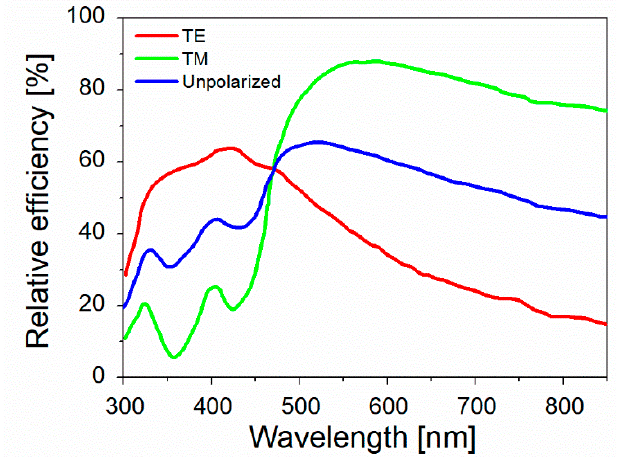
Figure 19. Example of reflectivity for an 1800 groove / mm grating optimized for use between 450 and 850 nm. Transverse electric (TE) indicate that the electric field of the radiation is polarized perpendicular to the plane of incidence; transverse magnetic (TM) indicate that the magnetic field of the radiation is polarized perpendicular to the plane of incidence; unpolarized is the average of TE and TM. Adapted with permission from Adar et al. [299].